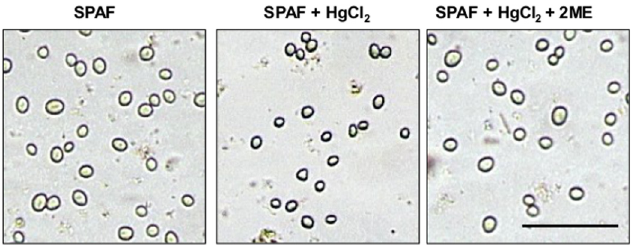
Fig 2. Effect of HgCl 2 , an inhibitor of AQPs function on swelling of spore of Rhizopus delemar . Treatment of R . delemar spores with 40 μ M HgCl 2 for 5 min inhibited spore swelling and germination. Additional treatment (5 min) with 5 μ M of the reducing agent 2- β -mercaptoethanol (2ME) fully reversed the inhibition effect. Pictures were taken 15 min and 3 h, in the upper and lower rows, respectively, after incubation in water or sweet potato active fraction (SPAF). Bar = 100 μ